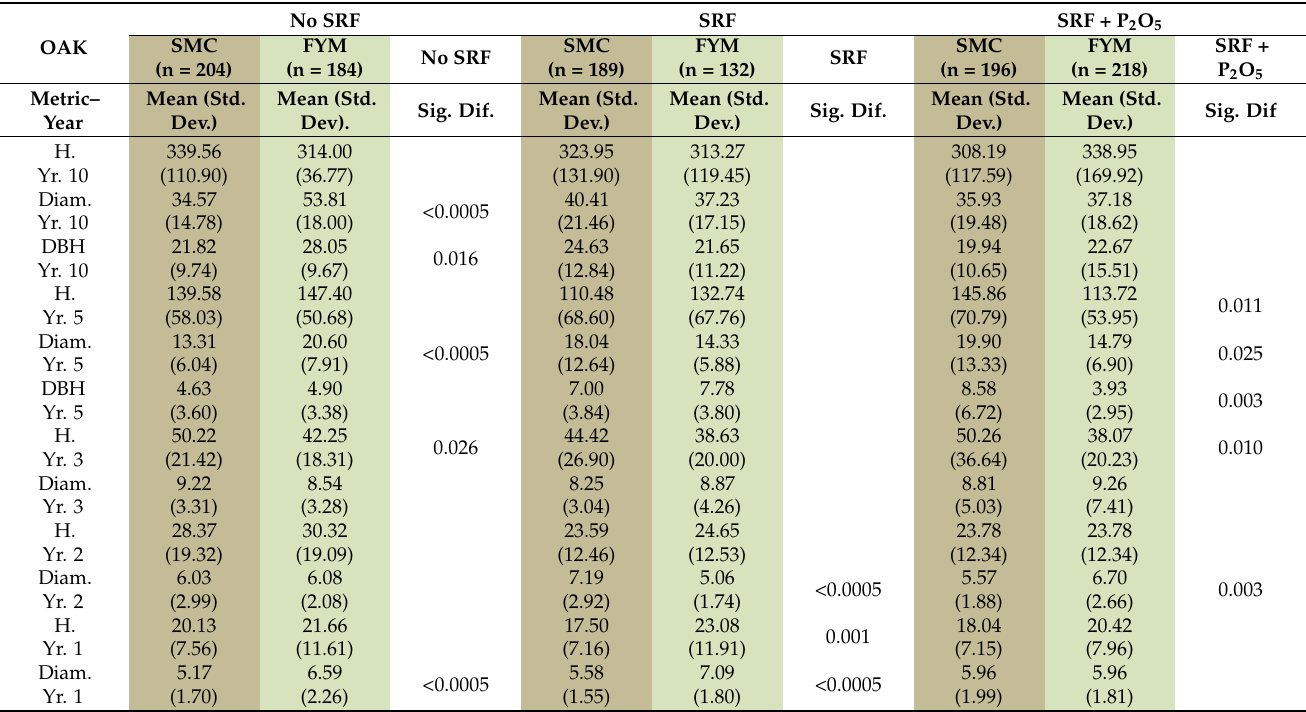
Table 11. Comparison of Oak with SMC- or FYM-planting compost and fertilizer. (Nb: height (H) cm; DBH: mm, Diam. (diameter above root collar): mm; ratio FYM/SMC; ns: differences not significant). No SRF SRF SRF + P 2 O 5 OAK Metric– Mean (Std. Year Dev.)